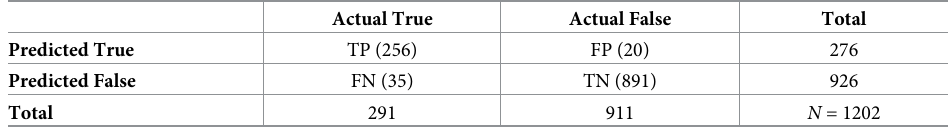
Table 9. Confusion matrix for MLP fully-supervised classification on the test data.